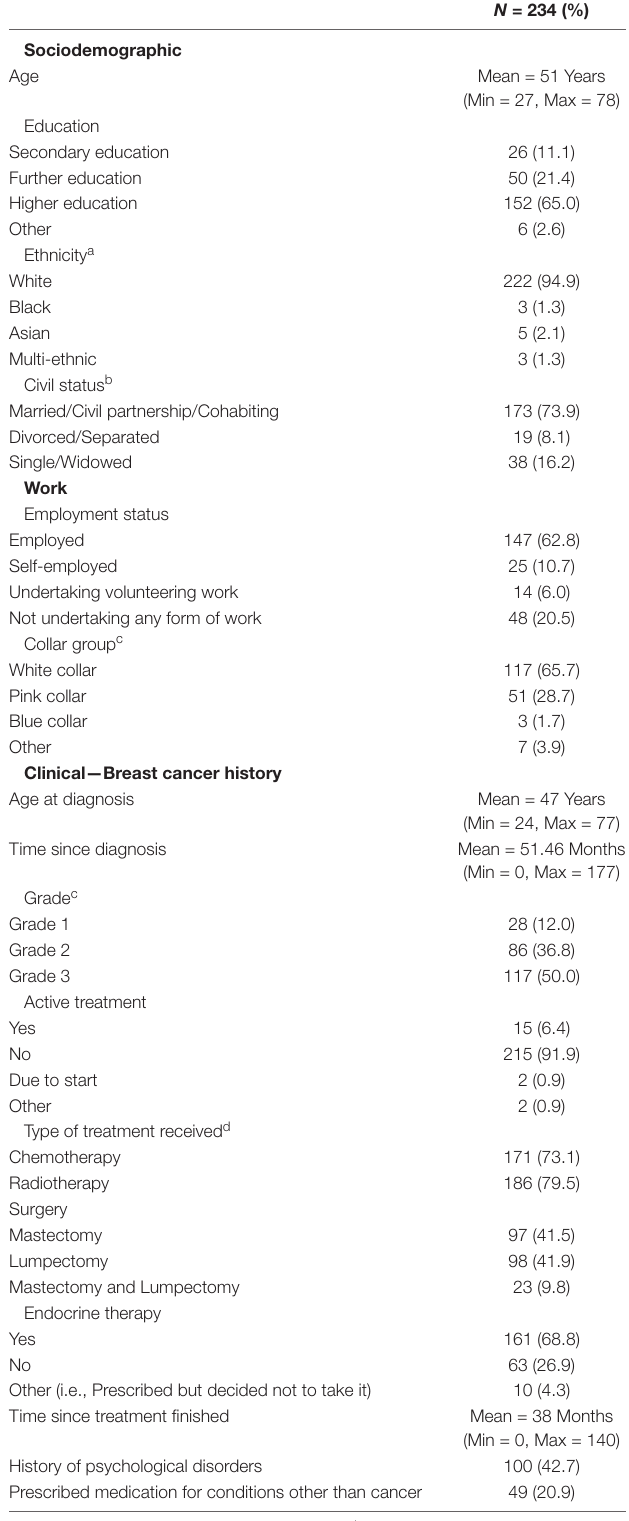
TABLE 1 | Clinical, sociodemographic, and work